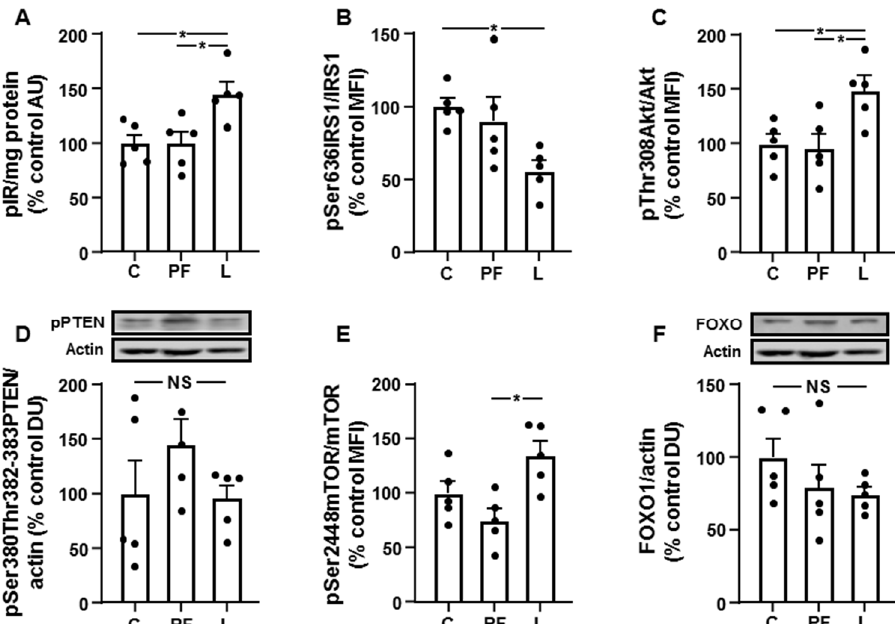
Figure 4. Leptin increases hepatic Akt signaling. Relative protein levels of ( A ) phosphorylated (p) insulin receptor (pIR), ( B ) insulin receptor substrate 1 (IRS1) phosphorylated at Ser636 (pSer636IRS1), ( C ) Akt phosphorylated at Thr308 (pThr308Akt), ( D ) phosphatase and tensin homologue deleted on chromosome 10 (PTEN) phosphorylated at Ser380 and Thr382-383 (pSer380Thr382-